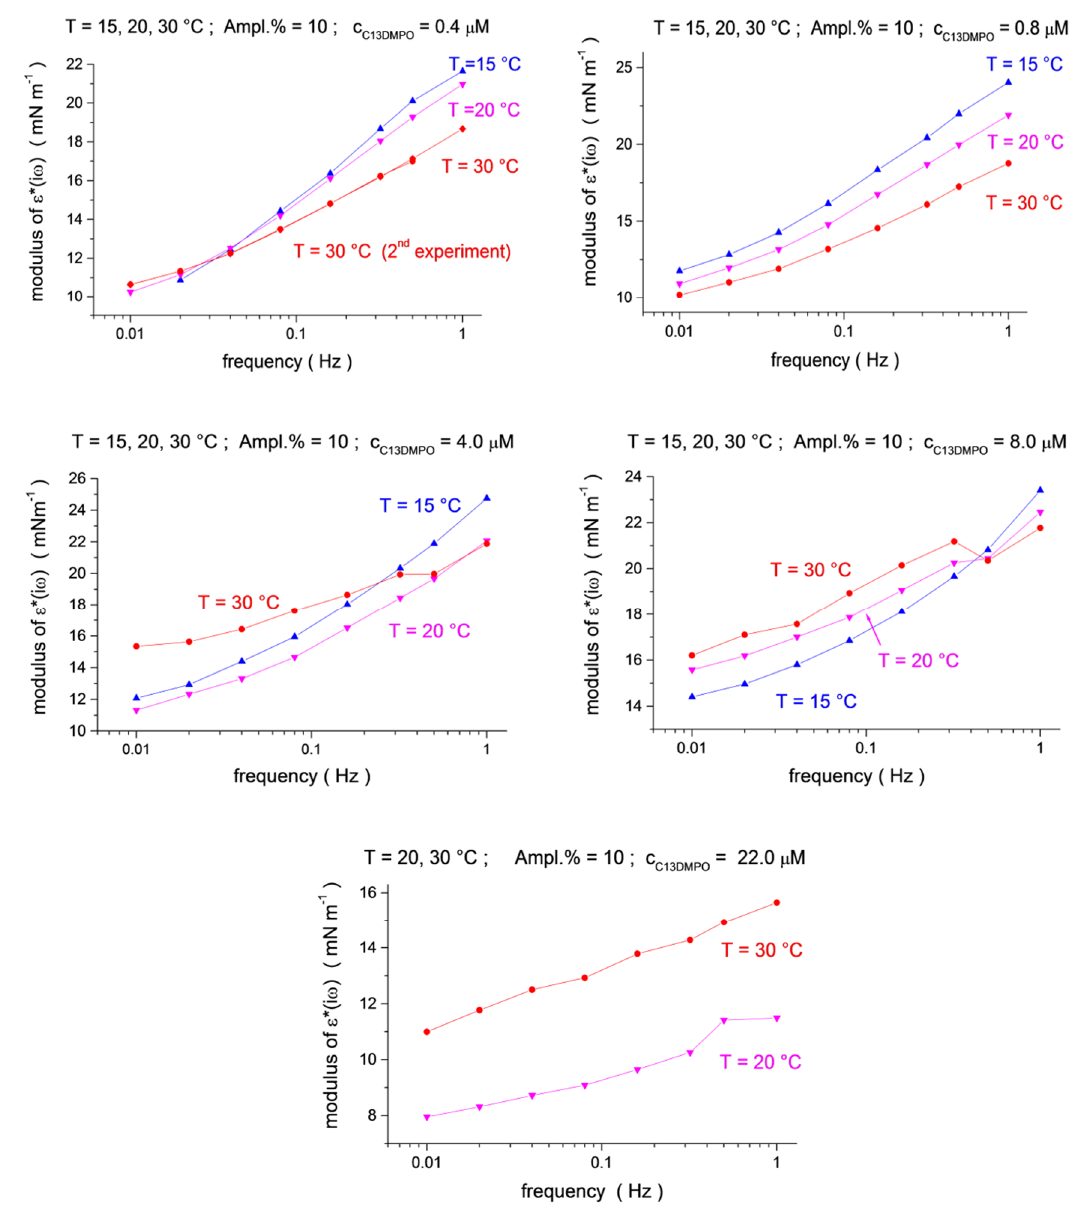
Figure 3. Temperature dependence (blue up triangles T = 15 °C, magenta down triangles T = 20 °C, red circles T = 30 °C) for the ε*(iω) modulus as a function of frequency (f = 0.01, 0.02, 0.04, 0.08, 0.16, 0.32, 0.5 and 1.0 Hz) at C 13 DMPO concentrations of c 1 = 4.0 × 10 −7 , 8.0 × 10 −7 , 4.0 × 10 −6 , 8.0 × 10 −6 and 2.2 × 10 −5 mol/dm 3 , at a fixed TTAB concentration of c 2 = 4.5 × 10 −5 mol/dm 3 .